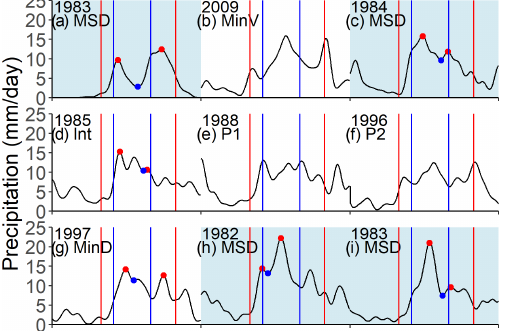
Figure 5. Daily precipitation time series for the year indicated in the upper left corner of each panel. Blue shading indicates the year is classified as an MSD using our original definition (Table 1 and Fig. 1). Key time windows from Table 1 are indicated by vertical lines: blue lines correspond to window 1, in which a minimum is identified, red lines to window 2, in which peaks must occur. Red dots indicate first and second maxima and blue dots mark the mini- mum if they meet MSD criteria. Examples shown are (a) a canoni- cal MSD pattern at point 4, (b) no minimum in window 1 at point 6, (c) a high minimum at point 5 but still an MSD, (d) insufficient in- tensity at point 5, (e) an early peak outside window 2 at point 6, (f) a second peak outside window 2 at point 6, (g) a lower minimum occurring in window 2 at point 5, and (h, i) a high variation in peaks at point 5.